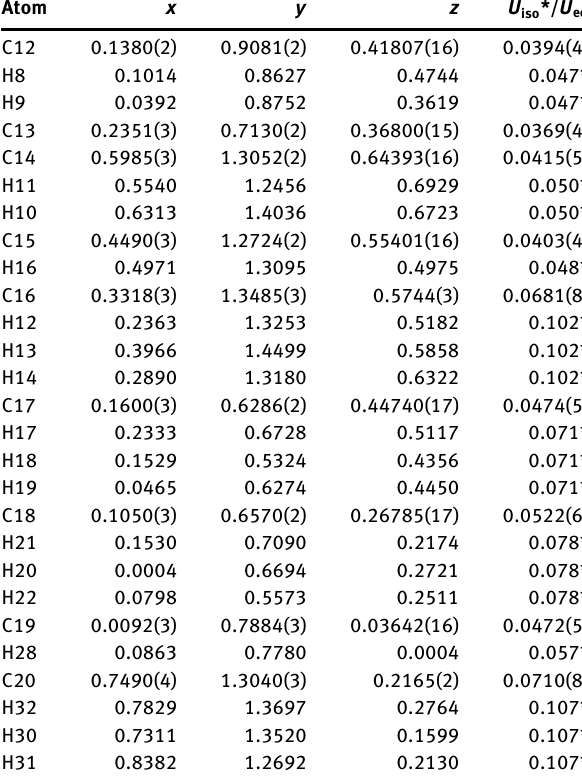
first isotropically and then anisotropically. All the hydrogen atoms of the ligands were placed in calculated positions with fixed isotropic thermal parameters and included in the struc- ture factor calculations in the final stage of full-matrix least- squares refinement. The U values of the hydrogen atoms of iso methyl groups were set to 1.5 U eq (C) and the U values of all iso other hydrogen atoms were set to 1.2 U eq (C,